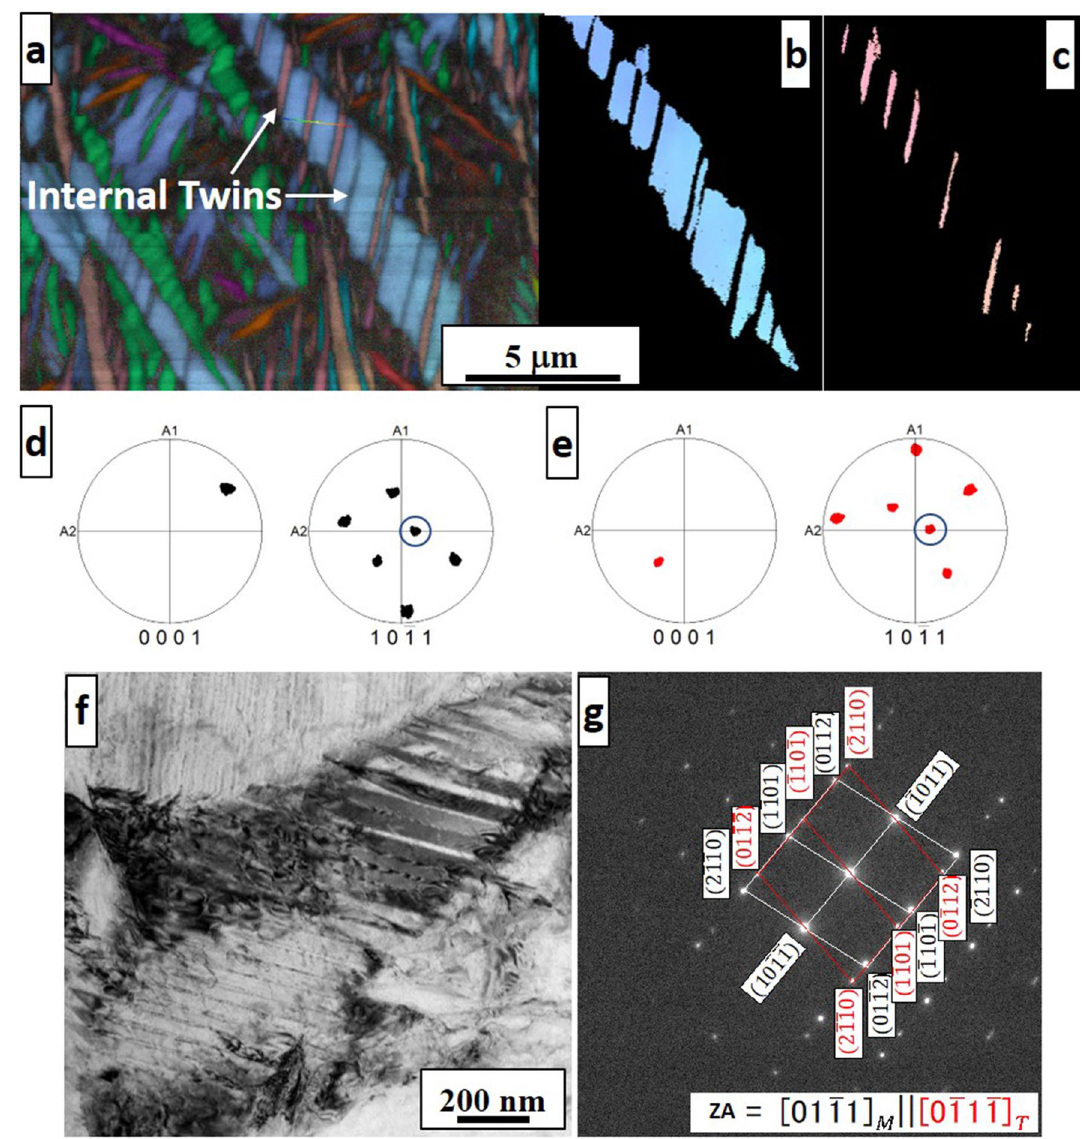
Figure 4. High resolution SEM-EBSD analysis of internally twinned martensite plates in the LPBF-AM Ti6Al4V sample. ( a ) Shows an inverse pole figure map with multiple internally twinned martensite plates. ( b , c ) Show IPF maps of a single plate with the matrix region and twinned region, respectively. Corresponding pole figures showing the {0001} and {10 ¯ 1 1} poles of the matrix region of the plate ( d ), and the twinned region of same plate ( e ), exhibit a common {10 ¯ 1 1} pole (marked with open circles). ( f ) Bright-field TEM image showing a high density of twins within a single martensite plate ( g ) Corresponding electron diffraction pattern recorded along a common [10 ¯ 1 1] type zone axis for both the matrix and the twin